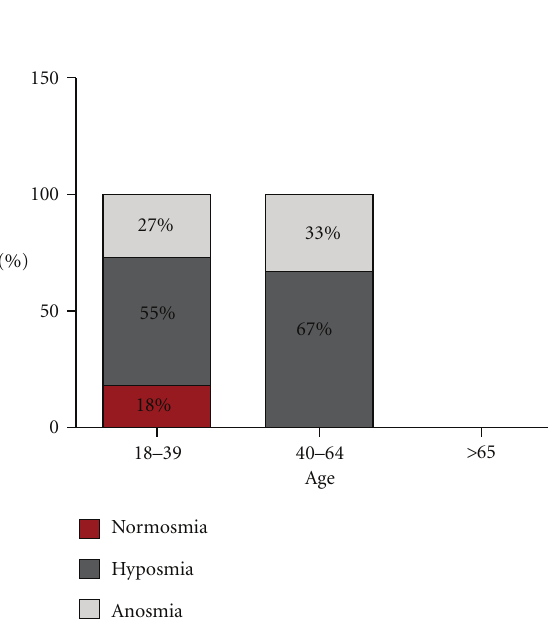
Figure 4: Clinical characteristics associated with olfactory dysfunc-